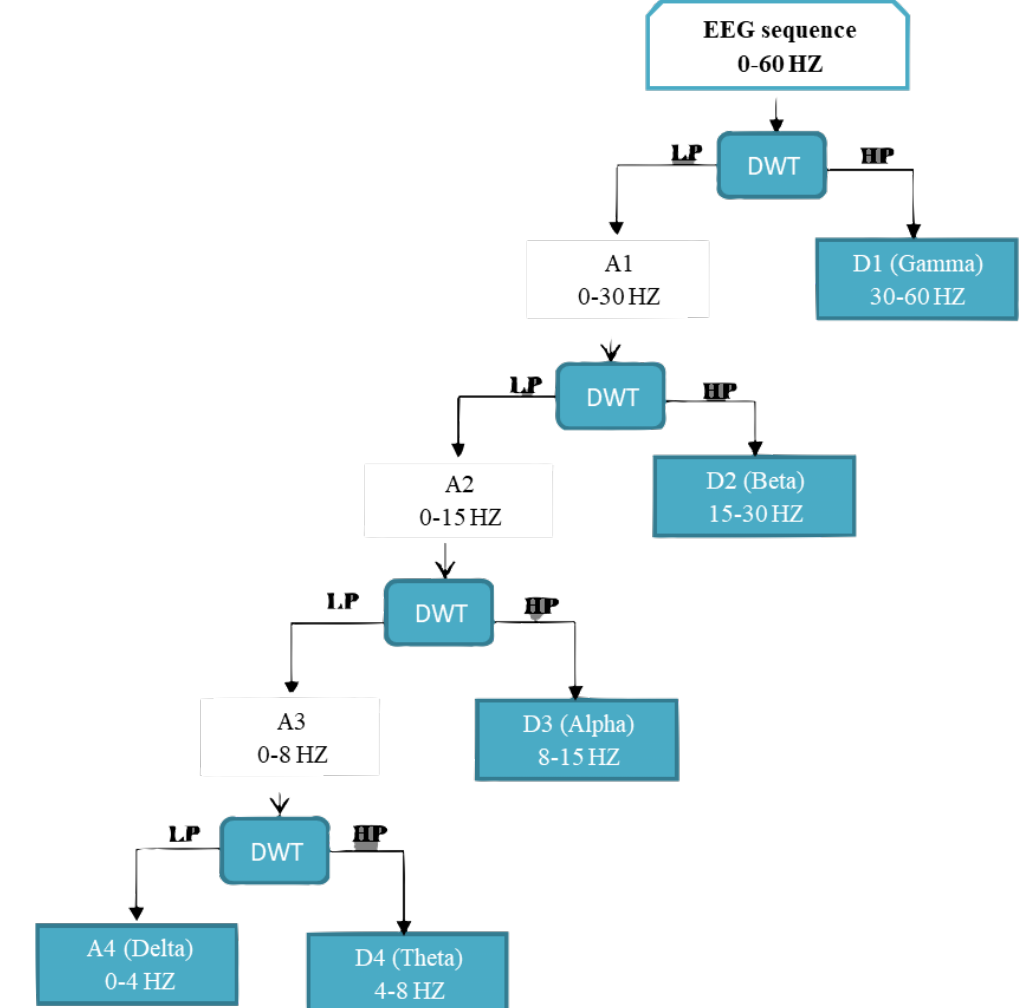
Figure 5. Decomposition of EEG signal into four levels by using